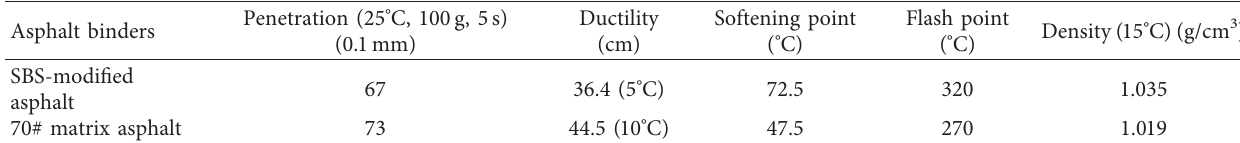
Table 4: Technical properties of the asphalt